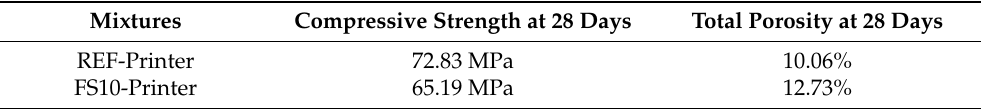
Table 3. Compressive strength and total porosity of REF-printed and FS10-printed by the gantry printer at 28